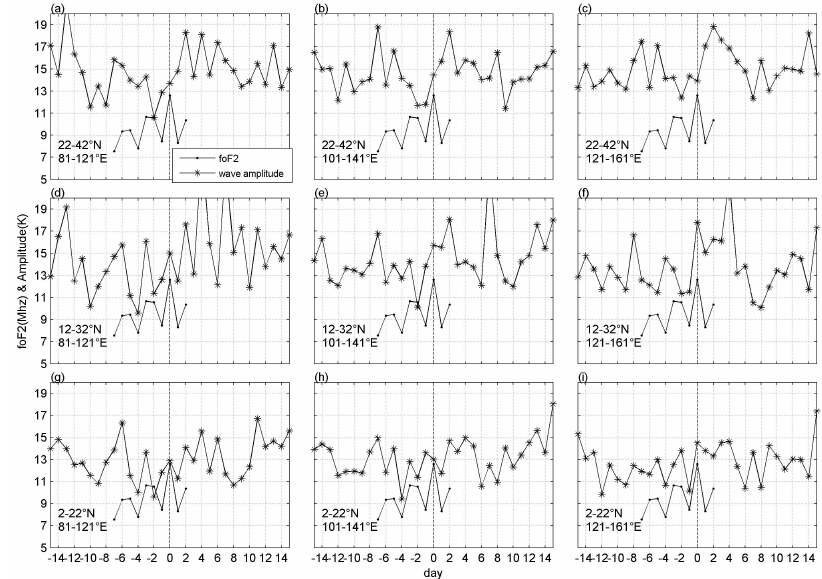
Fig. 10. The comparison of the foF2 and the intensity of the gravity wave in 9 areas for the Pingtung Doublet earthquake. The star line displays the daily maxima of the amplitude of the gravity wave of 20–30km wavelength and the point line denotes the daily maxima of the foF2. The vertical dotted dark lines denote the day of the earthquake occurrence.